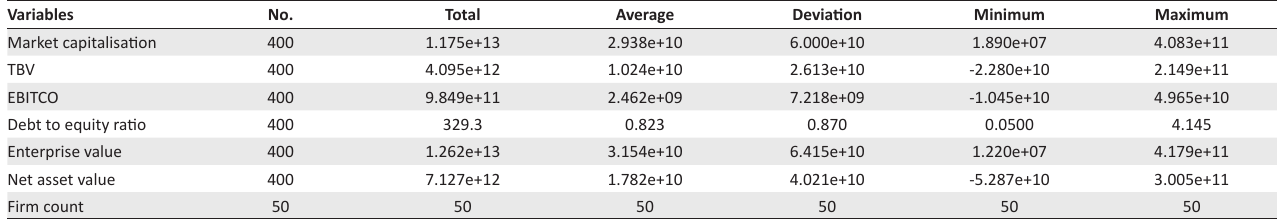
TABLE 3: Descriptive